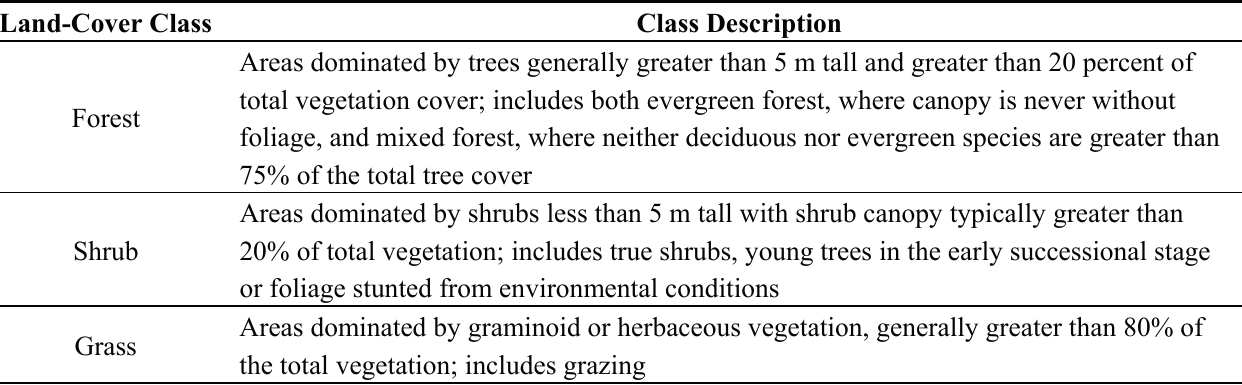
Table 3. Land cover classes based on the descriptions used for the National Land Cover Dataset